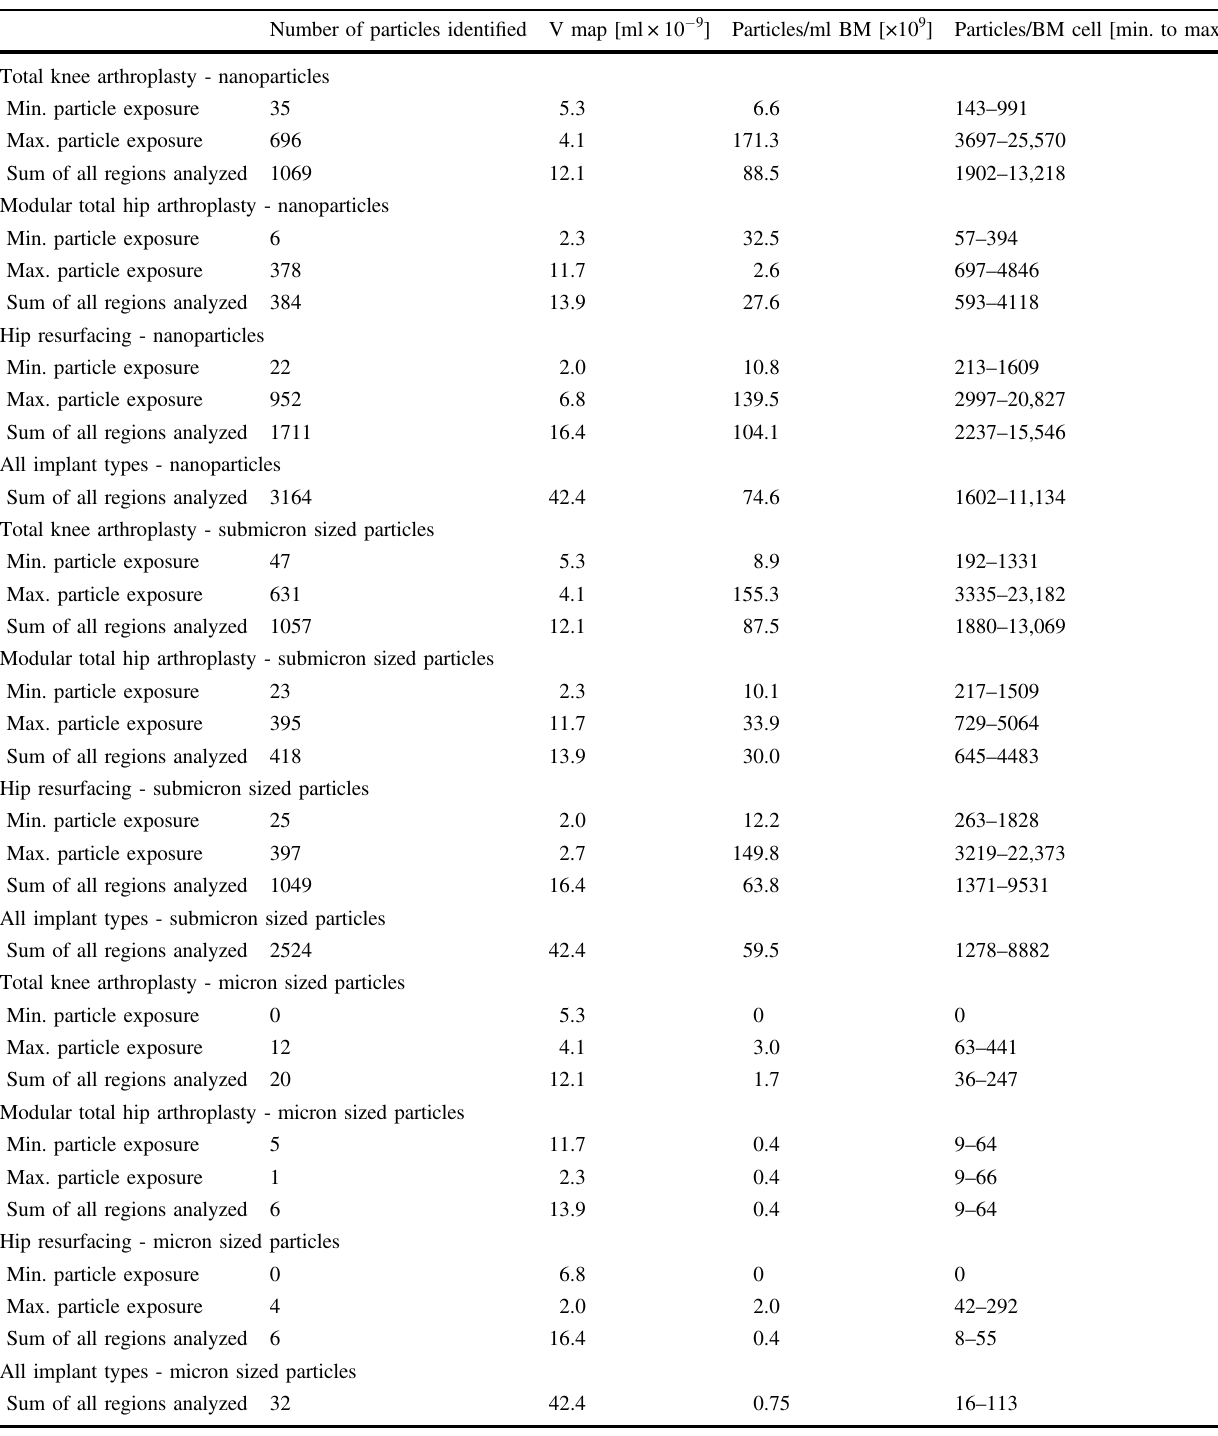
Table 2 Numbers of nano-, submicron-, and microparticles related to the sample speci fi c bone marrow volume and related to cell counts of native bone marrow samples to approximate particle numbers per bone marrow